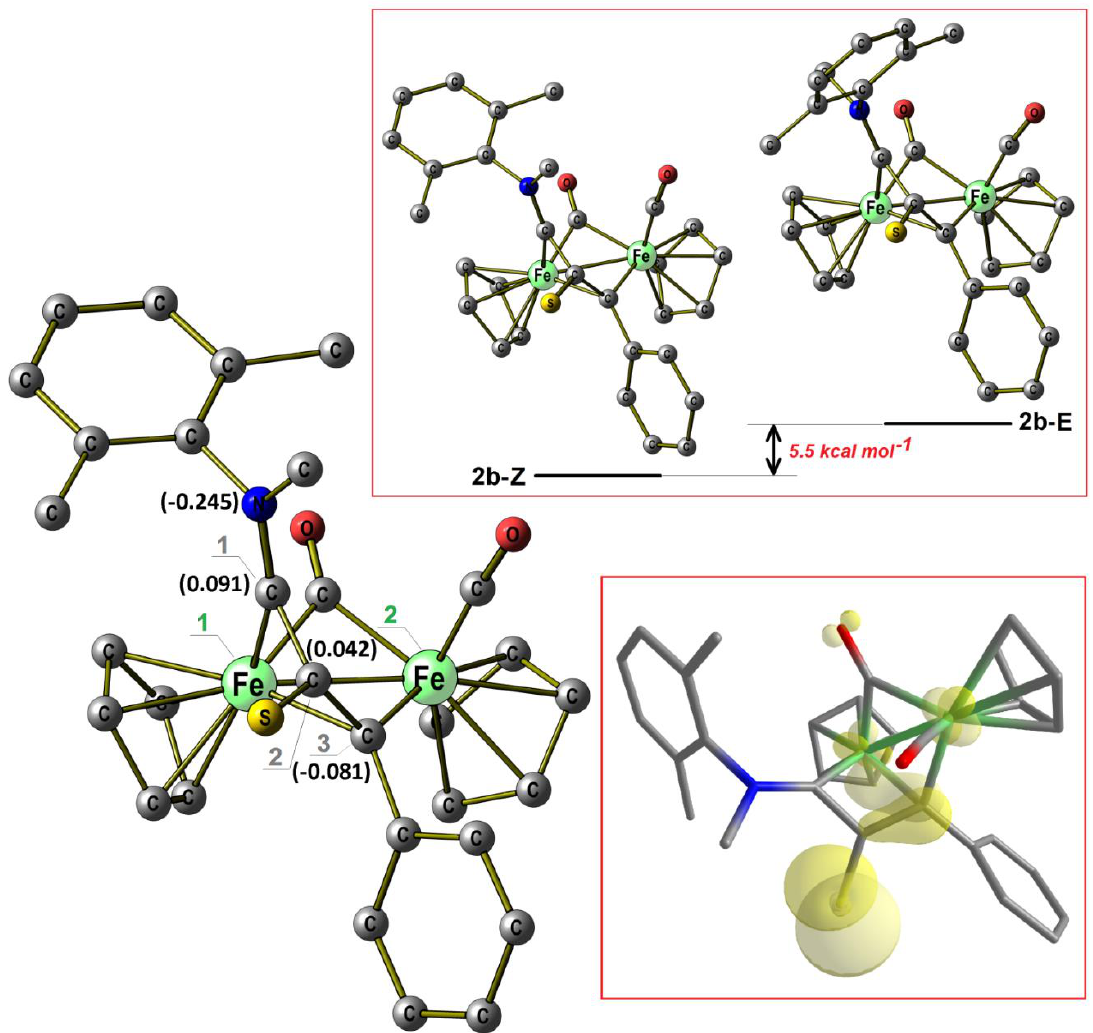
Figure 1. DFT-optimized structure of 2b , Z isomer (C-PCM / ω B97X / def2-SVP calculation, chloroform as continuous medium). Hydrogen atoms are omitted for clarity. Selected computed bond lengths (Å): Fe(1)-Fe(2) 2.534; Fe(1)-C( µ CO) 1.909; Fe(2)-C( µ CO) 1.902; Fe(1)-C(3) 2.033; Fe(2)-C(3) 1.977; Fe(2)-C(2) 2.143; Fe(1)-C(1) 1.878; Fe(2)-C(CO) 1.769; Fe(1)-Cp(average) 2.082; Fe(2)-Cp(average) 2.105; C(3)-C(2) 1.424; C(2)-C(1) 1.437; C(2)-S 1.732; C(1)-N 1.299. Selected computed angles ( ◦ ): Fe(1)-C(3)-C(2) 74.3; Fe(2)-C(3)-C(2) 123.2; C(1)-C(2)-C(3) 111.9; C(3)-C(2)-S 128.5; S-C(2)-C(1) 117.2; C(2)-C(1)-N 132.0. Selected Mulliken charges (a.u.) in parenthesis. Inset 1: Gibbs energy di ff erent between E and Z isomers of 2b (EDF2 / 6-31G** calculations). Cartesian coordinates of the EDF2 geometries are collected in the SI. Inset 2: HOMO of 2b (surface isovalue = 0.05 a.u.).